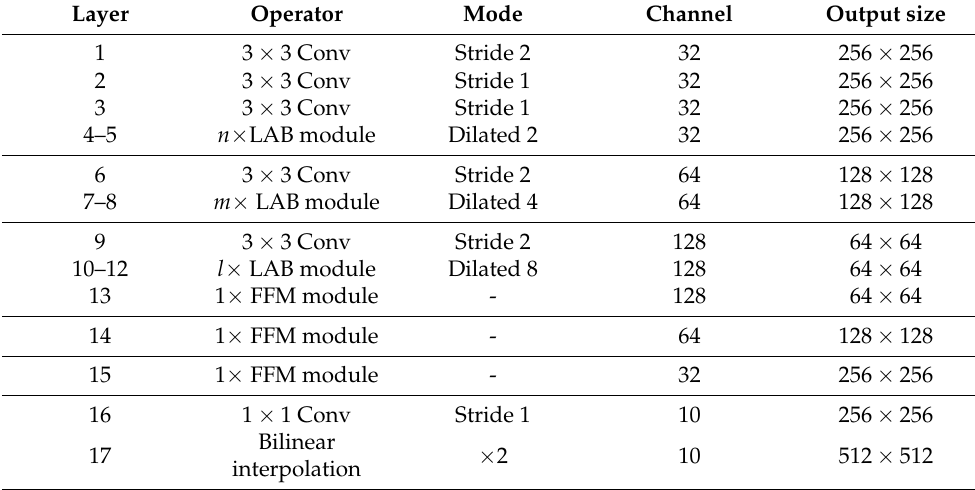
Table 1. Architecture details of the proposed